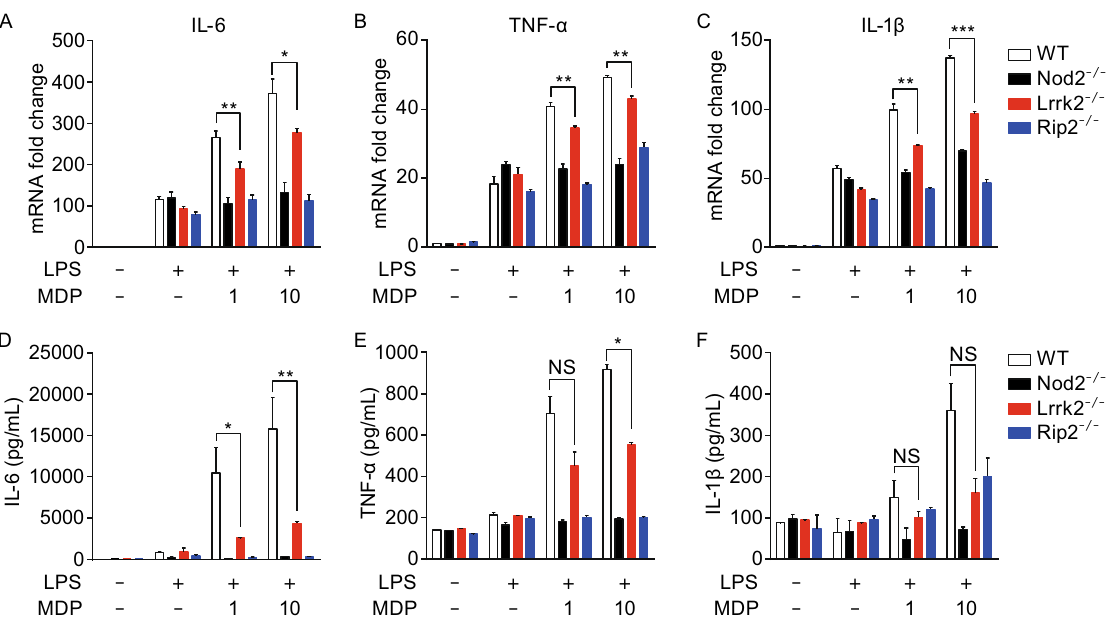
Figure 1. LRRK2 modulates cytokine production in BMDMs. (A – C) The relative fold changes of IL-6 (A), TNF- α (B), and IL-1 β (C) mRNA transcripts in WT, Nod2 − / − , Rip2 − / − and Lrrk2 − / − BMDMs treated with 5 ng/mL LPS and 1 or 10 μ g/mL MDP for 4 h, or mock- treated. (D – F) The amounts of IL-6 (D), TNF- α (E), and IL-1 β (F) in supernatants from WT, Nod2 − / − , Rip2 − / − and Lrrk2 − / − BMDMs treated with 5 ng/mL LPS and 1 or 10 μ g/mL MDP for 12 h, or mock-treated. Data are expressed as mean ± s.e.m. * P < 0.05, ** P < 0.01, *** P < 0.001, NS denotes not signi fi cant, by Student ’ s t -test. Data are representative of three independent experiments (A –